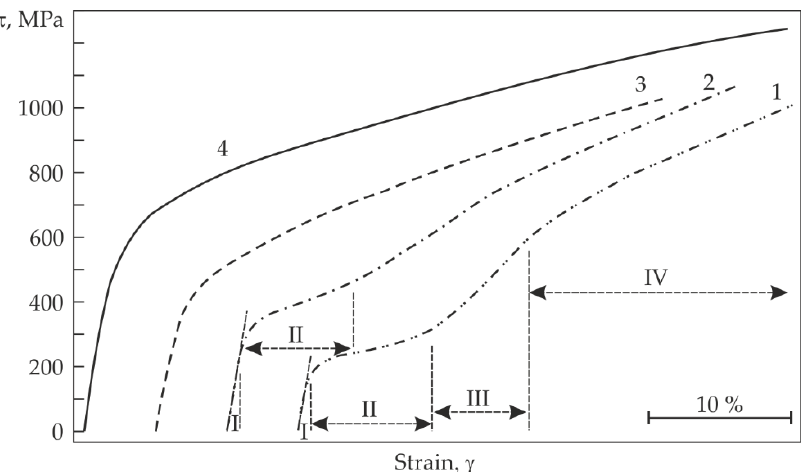
Figure 2. Stress–strain dependence of Ti 49.3 Ni 50.7 (at%) specimens deformed at 281 K (1), 299 K (2),